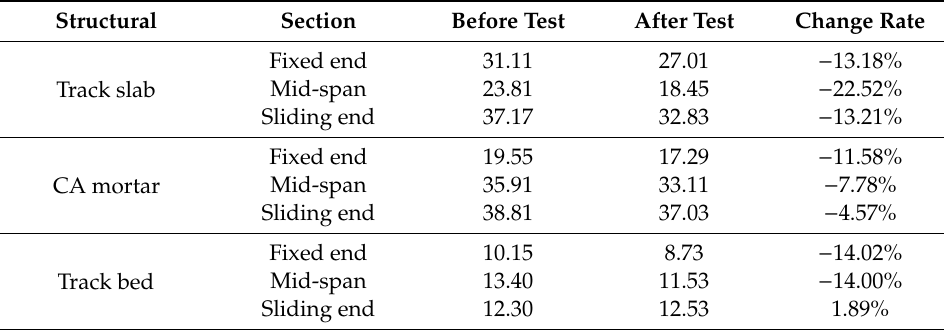
Table 3. Overall stiffness degradation of the track structure after thermal loading.